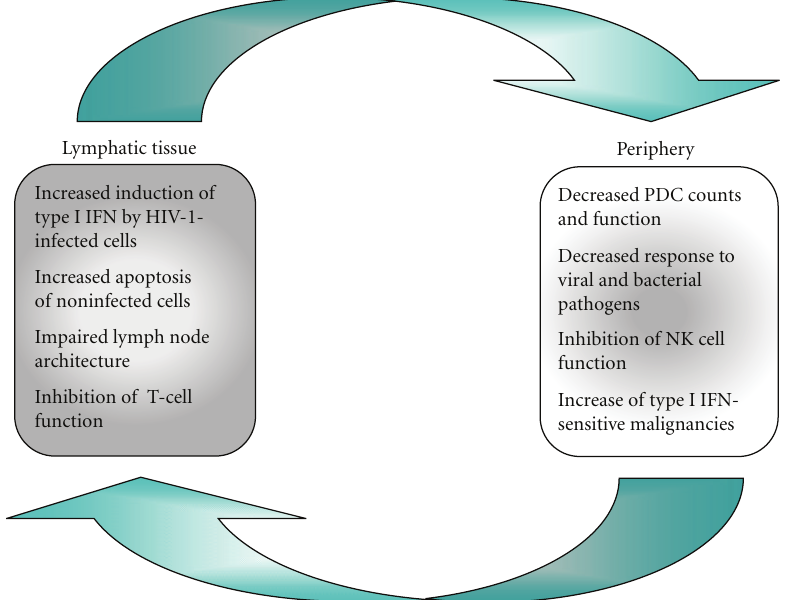
Figure 2: Vicious circle of type I interferon (IFN) induction in HIV-1 infection. The IFN-alpha induction is no longer balanced in HIV-1 infection. In the lymphatic tissue, plasmacytoid dendritic cells (PDC) are activated through direct cell-to-cell contact with HIV-1-infected cells, which creates an interferon-rich environment, promotes the apoptosis of uninfected T cells, inhibits T-cell functions, and destroys the lymph node architecture. In the periphery, reduced PDC counts and function result in an impaired innate immune response to bacterial and viral stimuli. Decreased natural killer (NK) cell functions may enhance the susceptibility to opportunistic infections and virus-induced tumor growth. The occurrence of pathogens in the periphery further causes PDC activation and depletion into lymphatic